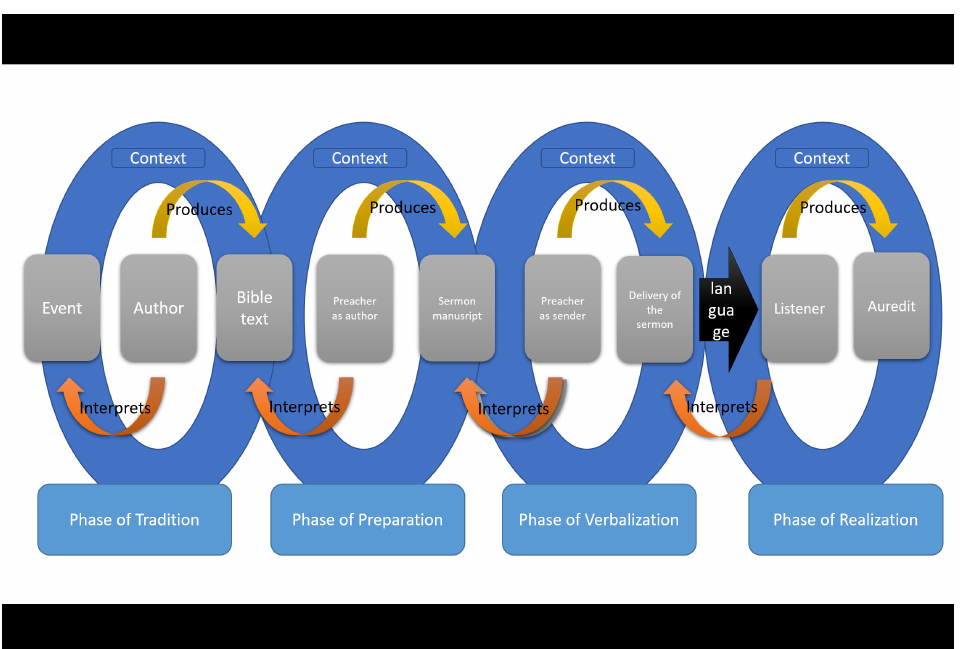
Figure 1. Engemann’s diagram of the preaching event.